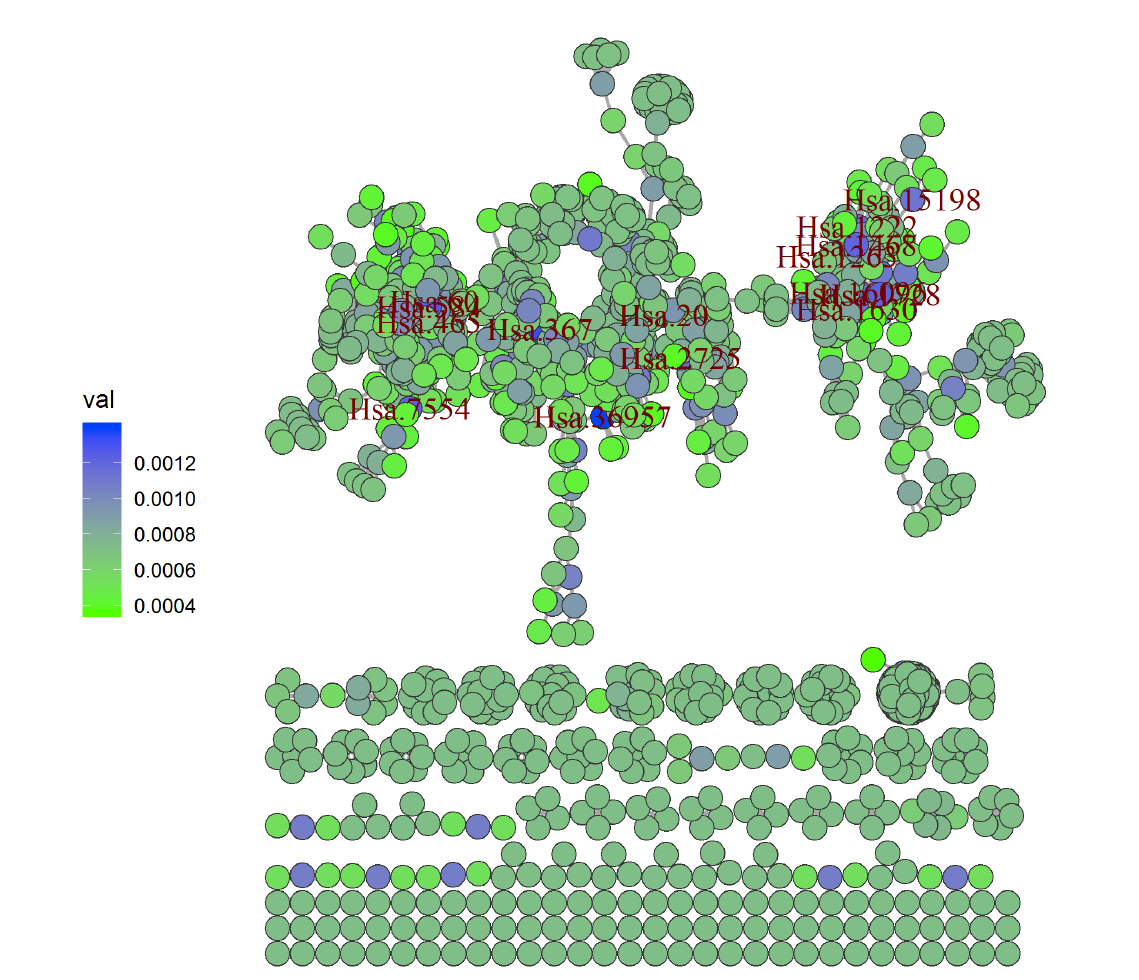
Figure 1. The graph represents the genes in colour based on LRI value. Affy-id of top fifteen genes in colon cancer dataset exhibiting highest LRI values are also